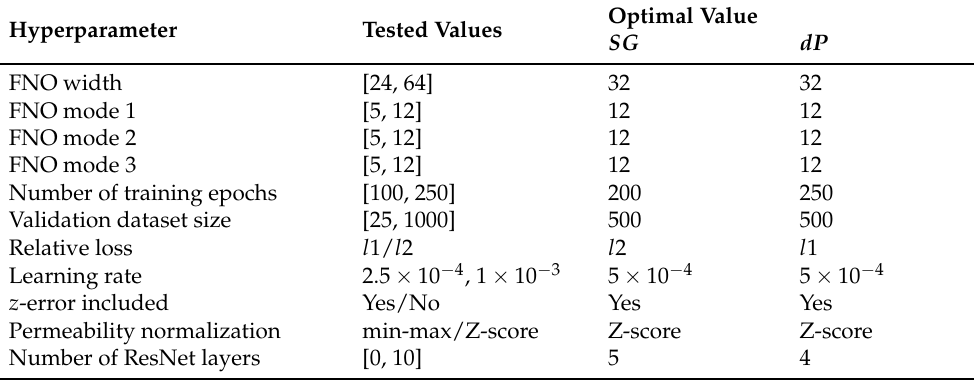
Table A2. The calibrated values of the hyperparameters for the gas saturation and pressure buildup models. Square brackets denote the lower and upper bounds of the tested range, while slashes signify that binary options were tested.